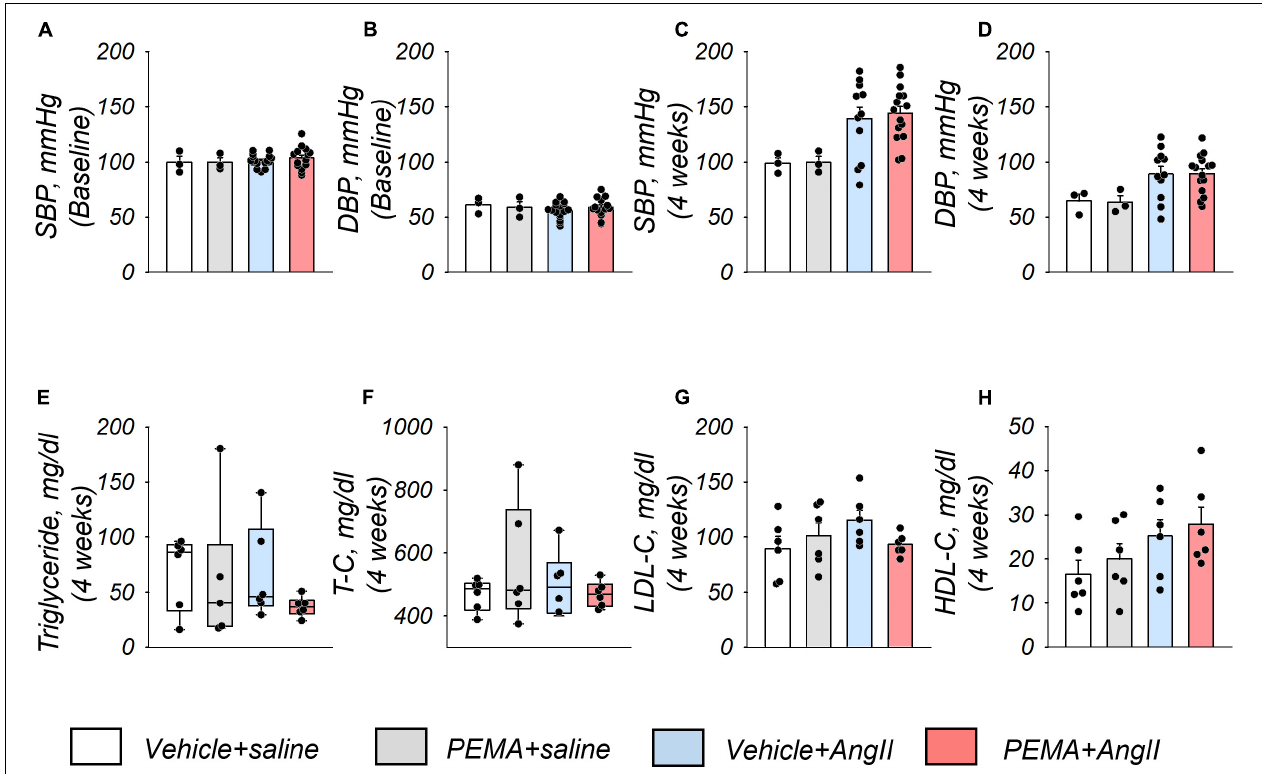
FIGURE 3 | Blood pressure and serum lipid profiles of study mice. Systolic blood pressure (SBP) and diastolic blood pressure (DBP) at the start of the experiment (baseline) (A,B) and 4 weeks after the administration of AngII or saline infusion (C,D) in each group. Sample size: n = 3 (vehicle + saline and PEMA + saline group] and n = 11–16 (vehicle + AngII and PEMA + AngII group) in triplicate. Samples that matched the median body weights of each group were selected. Serum levels of triglycerides, total cholesterol (T-C), low-density lipoprotein cholesterol (LDL-C), and high-density lipoprotein cholesterol (HDL-C) 4 weeks after the administration of AngII or saline infusion in each group (E–H) , respectively. Sample size: n = 6 per group. Samples that matched the median body weights of each group were selected. Data are expressed as mean ± standard error of the mean and analyzed by one-way analysis of variance for normally distributed continuous variables (A–D,G,H) or expressed as median (interquartile range) and analyzed using the Kruskal–Wallis test (E,F) . p <